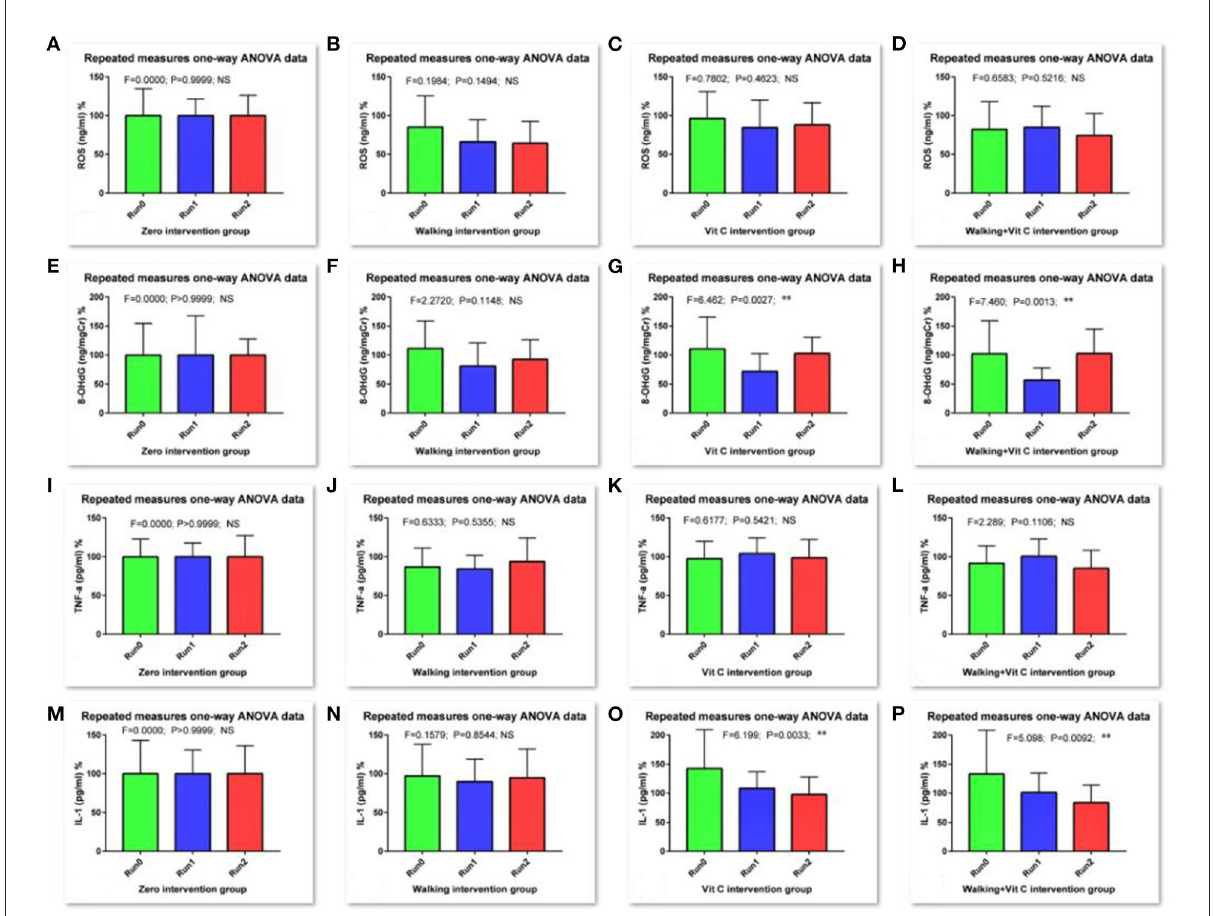
FIGURE2 Results of RM-ANOVA. [ (A–D) are for ROS in Run0, Run1 and Run2 groups, (E–H) are for 8-OHdG in Run0, Run1 and Run2 groups, (I–L) are for TNF- α in Run0, Run1 and Run2 groups, and (M–P) are for IL-1 β in Run0, Run1 and Run2 groups. Comparison for research courses with RM-ANOVA, *: the difference is significant ( p < 0.05); **: the difference is very significant ( p <